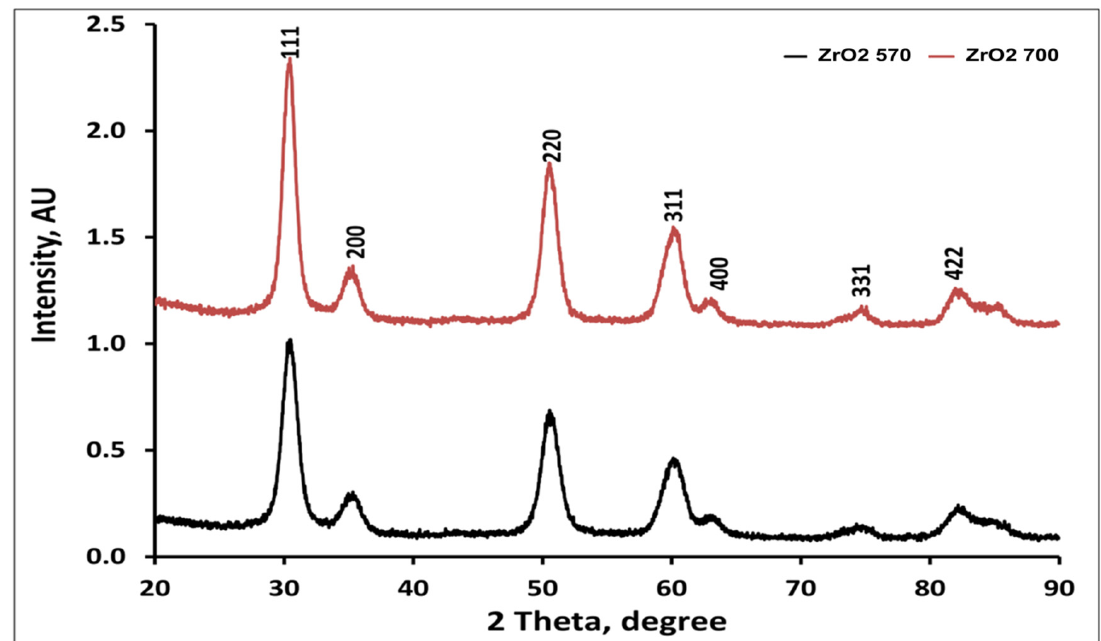
Figure 1. XRD patterns of ZrO 2 NPs570 and ZrO 2 NPs700. Table 1. Crystallite size, BET surface area, and pore dimensions of ZrO 2 NPs570 and ZrO 2 NPs700.